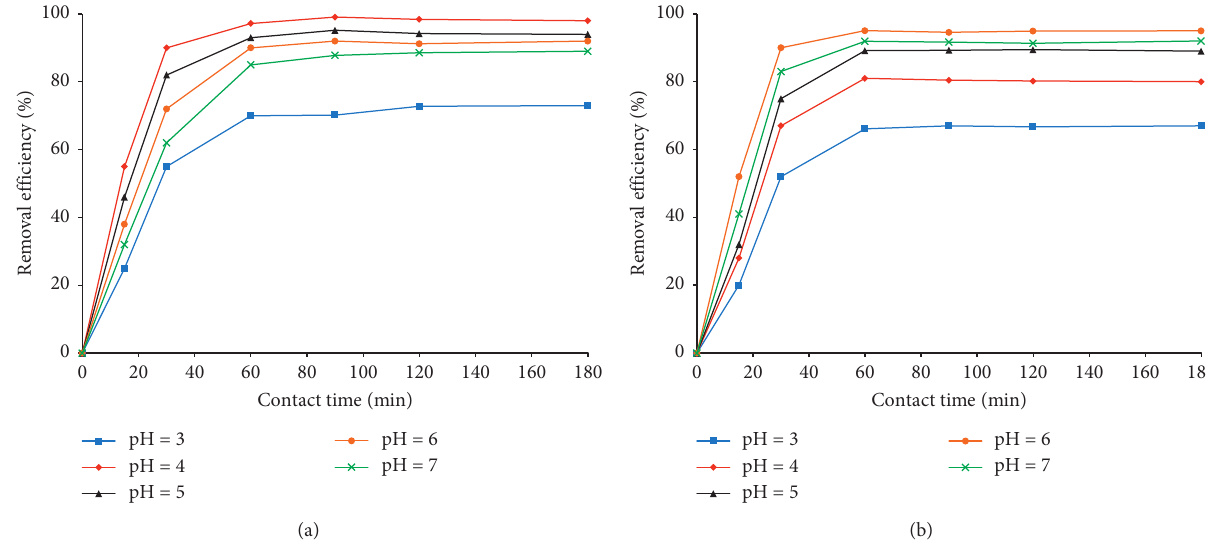
Figure 2: Removal efficiencies of Pb +2 and Ni +2 ions onto WFS at different values of contact time and initial pH. (a) Lead (dosage � 2.5g/ 100mL, C o � 50mg/L, and speed � 250rpm). (b) Nickel (dosage � 2.5g/100 mL, C o � 50mg/L, and speed �